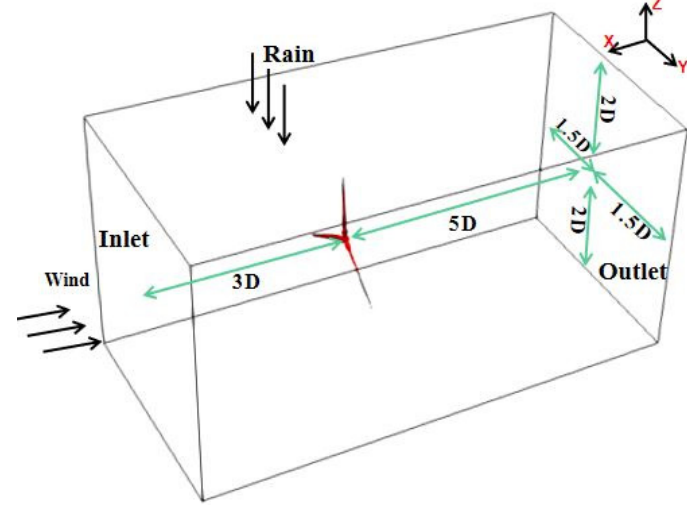
Figure 2. Computing domain settings.